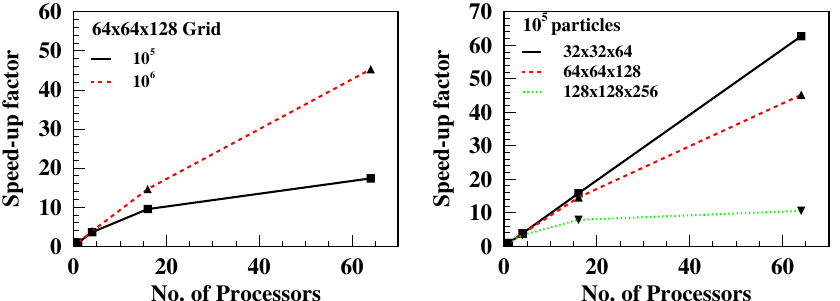
FIG. 12. (Color) Performance test results of the parallel version of TRACK . The left plot compares the speedup factor for the same SC grid 64 (cid:3) 64 (cid:3) 128 and different number of particles: 10 5 and 10 6 . The right plot compares the speedup factor for the same number of particles ( 10 6 ) but different SC